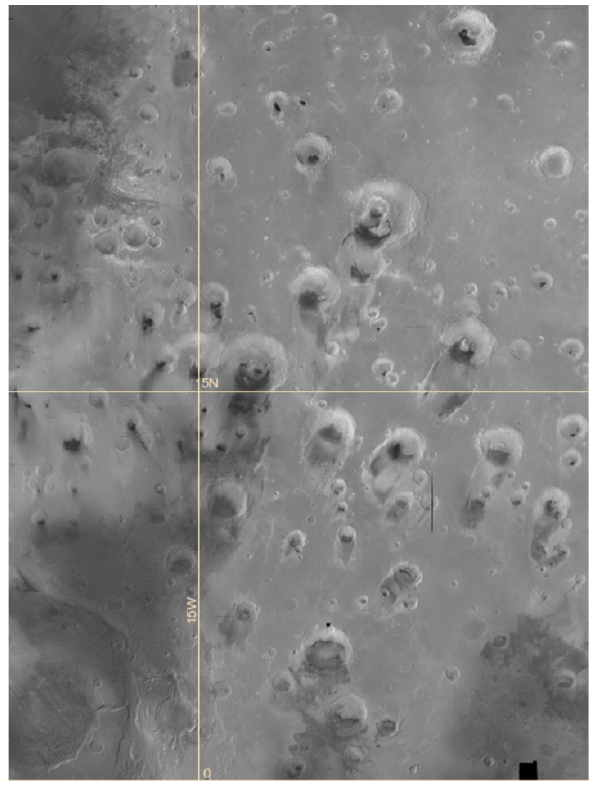
Figure 1. A snapshot of the MC11-E quadrangle mosaic that was released by the HRSC team.